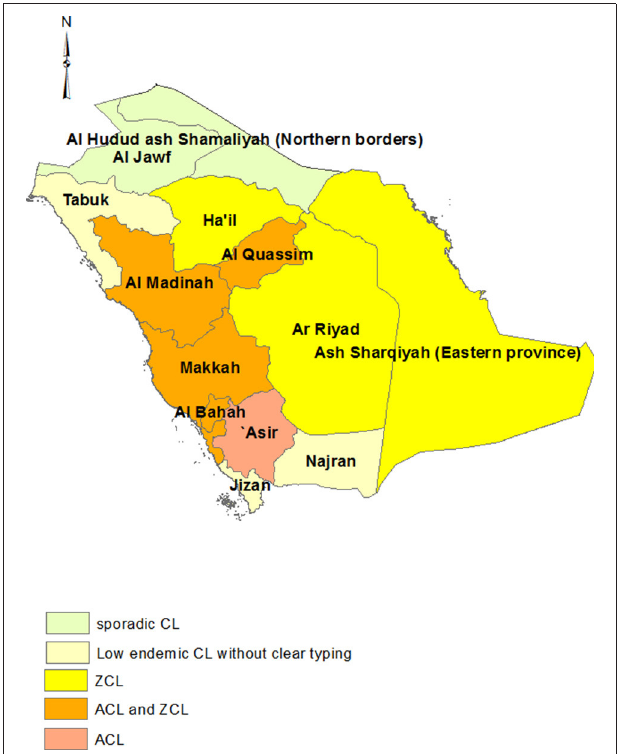
FIGURE 3 | Distribution of CL types in Saudi Arabia. FIGURE 4 | Distribution of CL types in